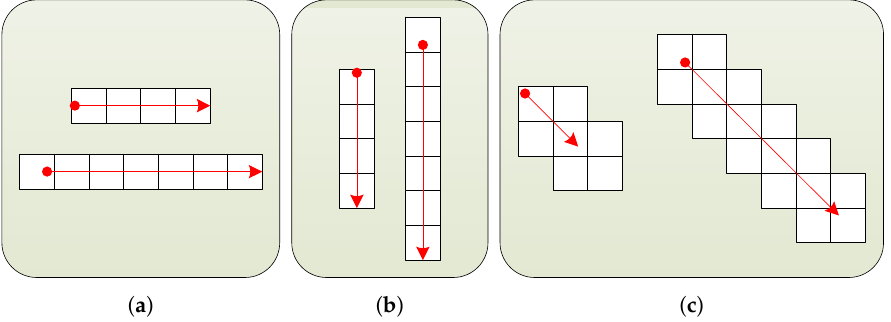
Figure 7. Schematic diagram of distance constraint for a target pair. ( a ) Horizontal direction, ( b ) Ver- tical direction, ( c ) Diagonal